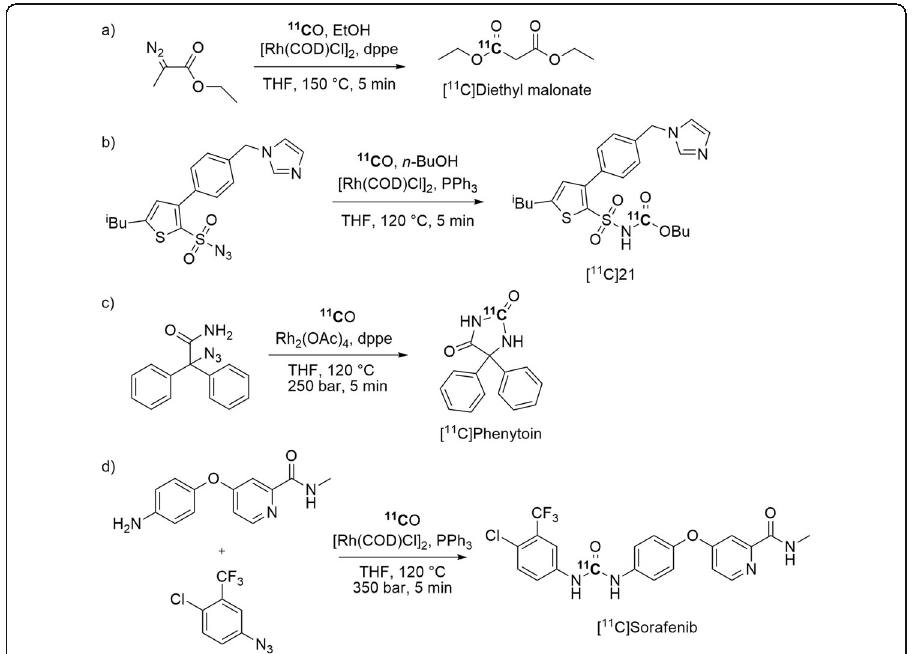
Fig. 32 Rh-Mediated synthesis of: a [ 11 C]diethyl malonate; b an agonist of AT 2 R, [ 11 C]21; c [ 11 C]phenytoin;